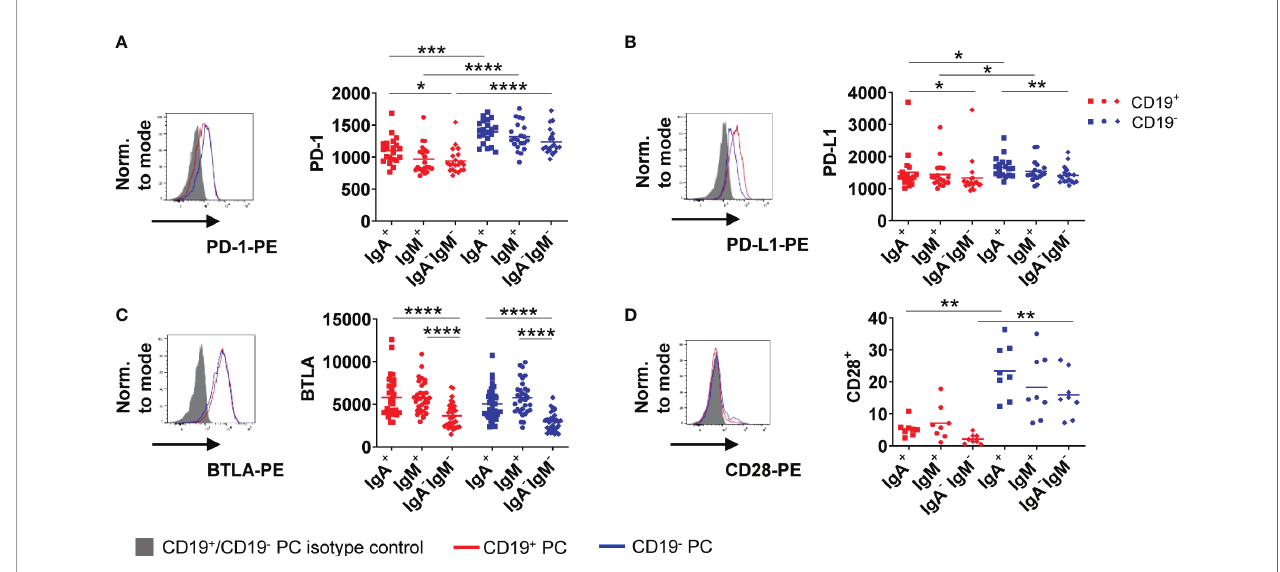
FIGURE 4 | CD19 − BMPC express higher levels of PD-1 than CD19 + . Baseline expression of PD-1 ( A , MFI), PD-L1 ( B , MFI), BTLA ( C , MFI) and CD28 ( D , frequency) was assessed in IgA + , IgM + and IgA − IgM − BMPC. A representative histogram with the respective isotype control staining ( fi lled grey histogram: isotype control, solid lines: staining of CD19 +/ − BMPC) and cumulative data is shown (n = 8 – 33) for IgA + , IgM + and IgA − IgM − BMPC. Bars indicate mean. ****p < 0.0001, ***p < 0.001, **p < 0.01, *p < 0.05 by Friedman-Test with Dunn ’ s correction for multiple